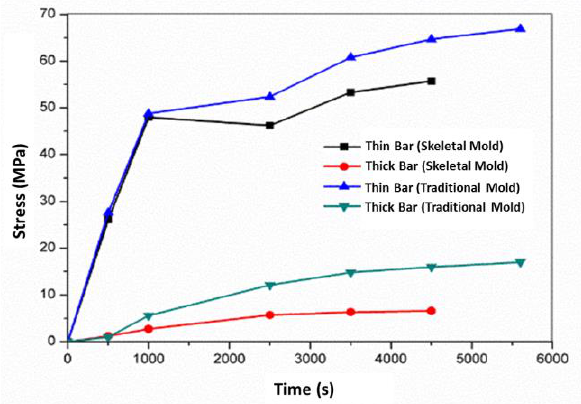
Figure 17. Stress evolution during the casting process in the casting.